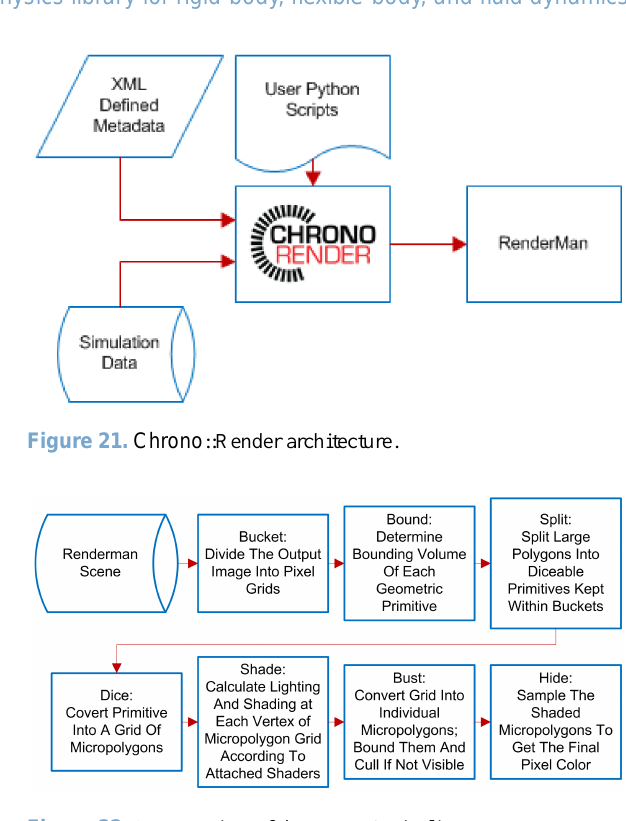
Figure 22. An overview of the REYES Figure 22 : An overview of the REYES Pipeline.